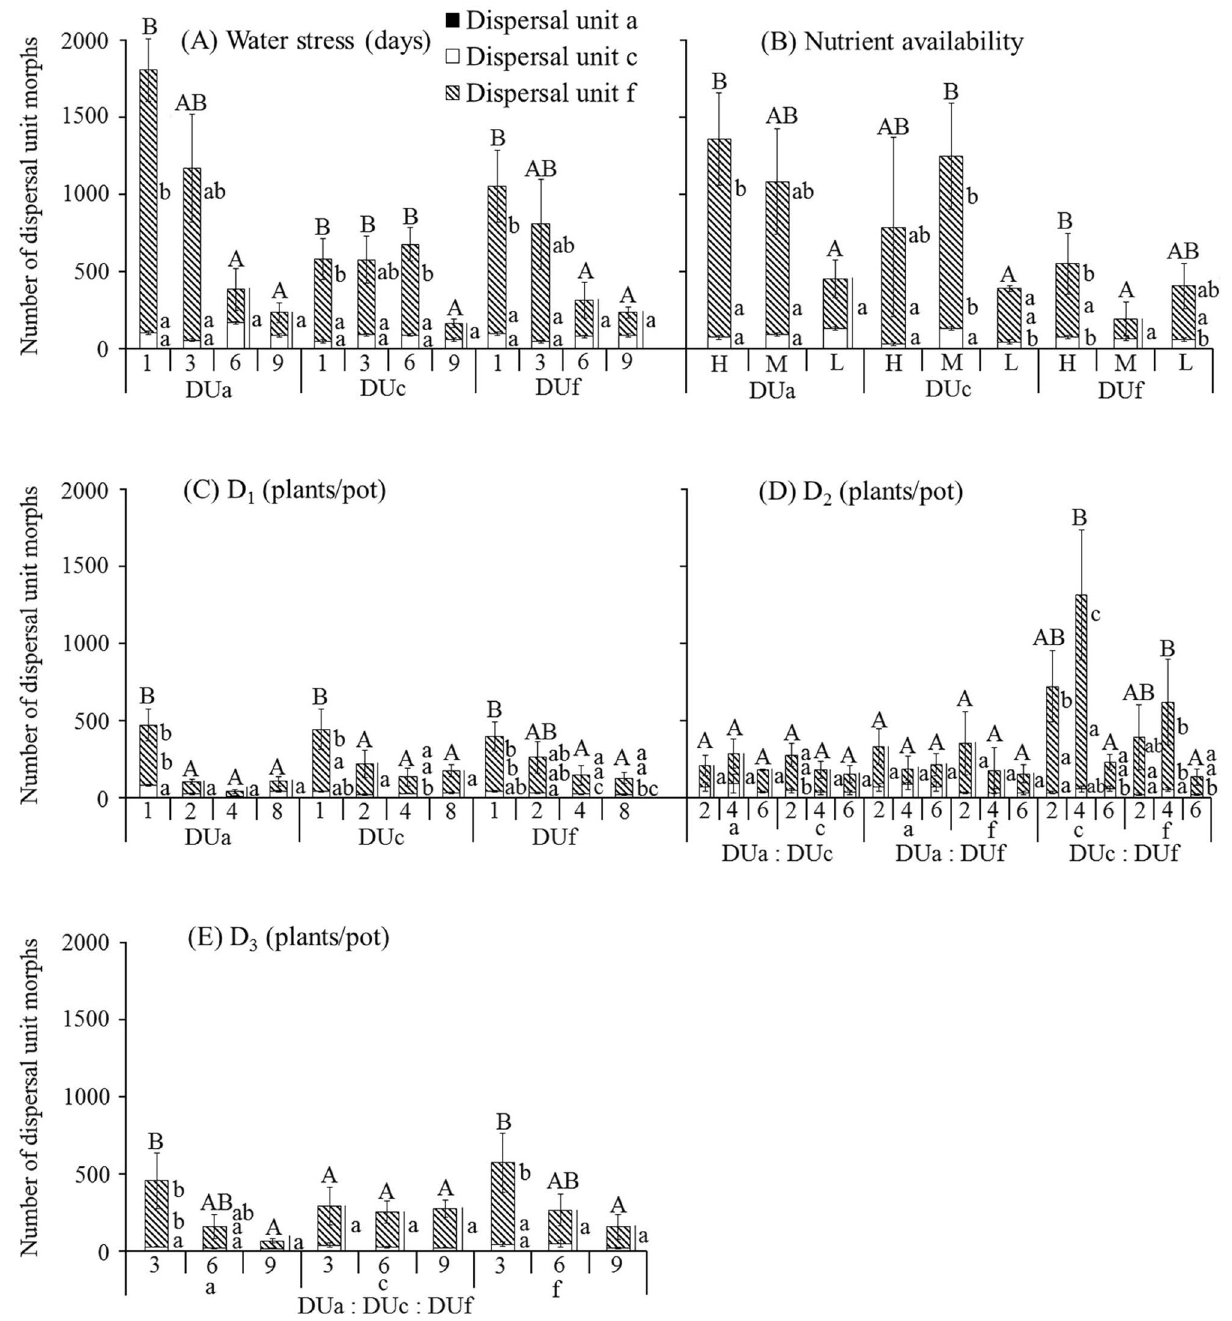
Figure 5. Effect of water stress ( A ), nutrient availability ( B ) and pure ( C ) and mixed ( D , E ) density on number of dispersal unit morphs a, c and f of Ceratocarpus arenarius plants derived from each dispersal unit morph (mean ± 1 s.e.). Only numbers of each dispersal unit morph ≥ 21.00 and standard errors ≥ 4.34 are shown. Different uppercase letters indicate significant differences in total number of the three dispersal unit morphs and different lowercase letters significant differences in number of each of the three dispersal unit morphs among levels for all treatments of plants from the same dispersal unit morph (P < 0.05). DUa, dispersal unit morph a; DUc, dispersal unit morph c; DUf, dispersal unit morph f; H, high; M, moderate; L, then, the (HDi-LDo)/(LDi-HDo) ratio decreased with increasing stress in C. arenarius (Fig. 6; Table 3). In the heterodiasporous species Lappula duplicicarpa 19 , Atriplex aucheri 38 and Heterosperma pinnatum 26 , the dispersal unit morph number ratio can vary, depending on the environment conditions under which the mother plants are grown. This diaspore number ratio also varies in the amphicarpic sensu lato species Catananche lutea 22 , Emex spinosa 39 and Gymnarrhena micrantha 40 , the amphicarpic sensu stricto species Amphicarpum purshii 41,42 and Mimulus nasutus with aerial chasmogamous and cleistogamous fruits 43 . In amphicarpic species, aerial diaspores